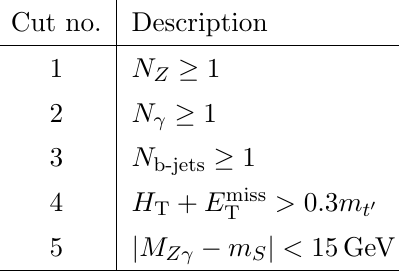
for m S = 160 GeV and m t 0 = 1400 T